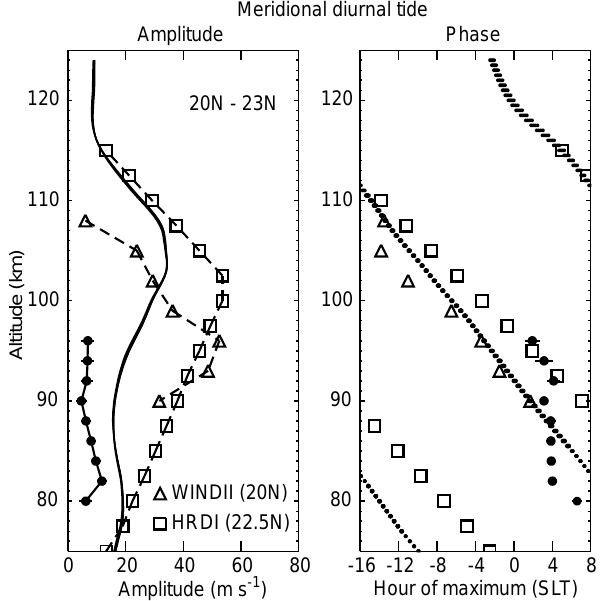
Fig. 13. The amplitude ( left ) and phase ( right ) of the meridional diurnal tide from 18 (cid:14) to 23 (cid:14) N. The results for Kauai, WINDII at 20 (cid:14) N ( diamonds ), HRDI at 22.5 (cid:14) N (squares) and the GSWM (amplitude: solid line , phase: dots )